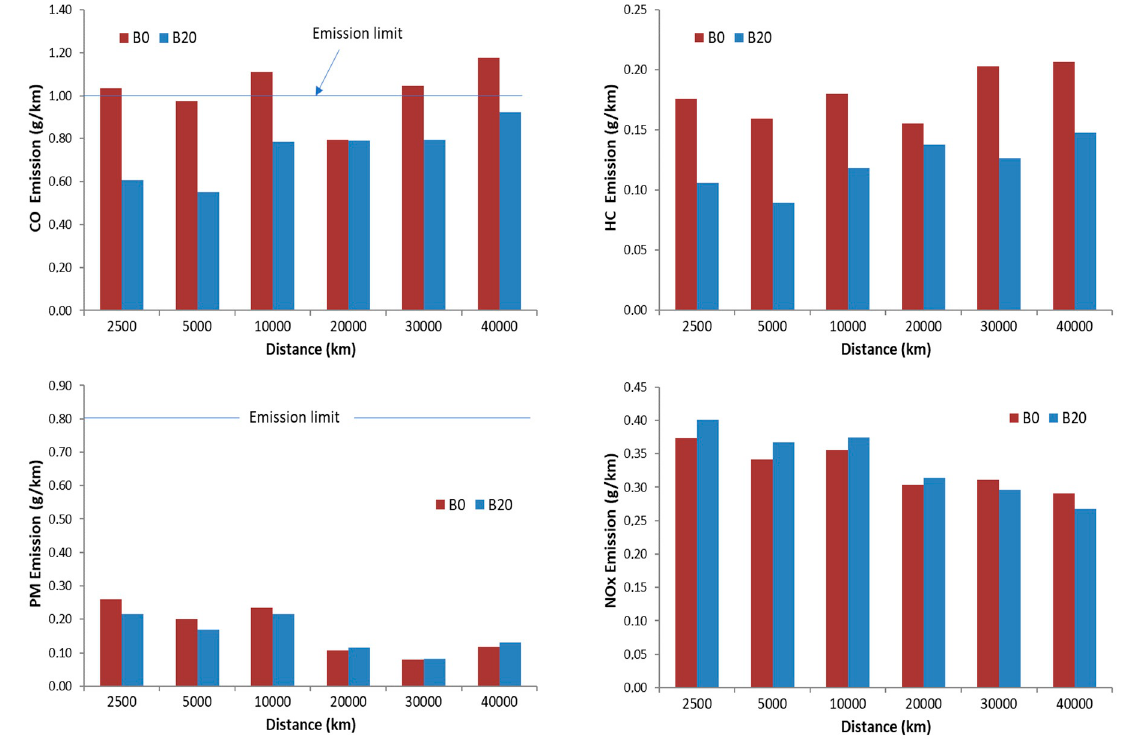
Figure 3. CO, hydrocarbon (HC), NOx and Particulate Matter (PM) emission for B0 and B20 at each traveled distance.